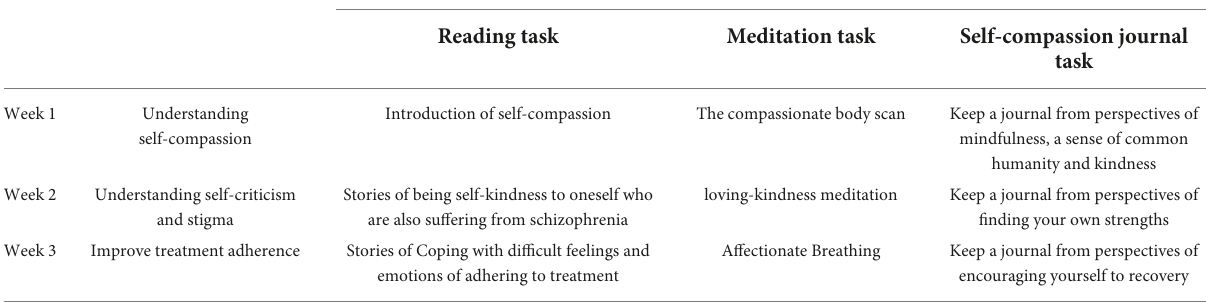
TABLE 1 Key themes of the “Self-compassion Tour”. Week Theme Task Reading task Meditation